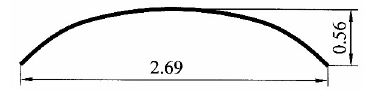
Fig 4. Deformations identified on the section of